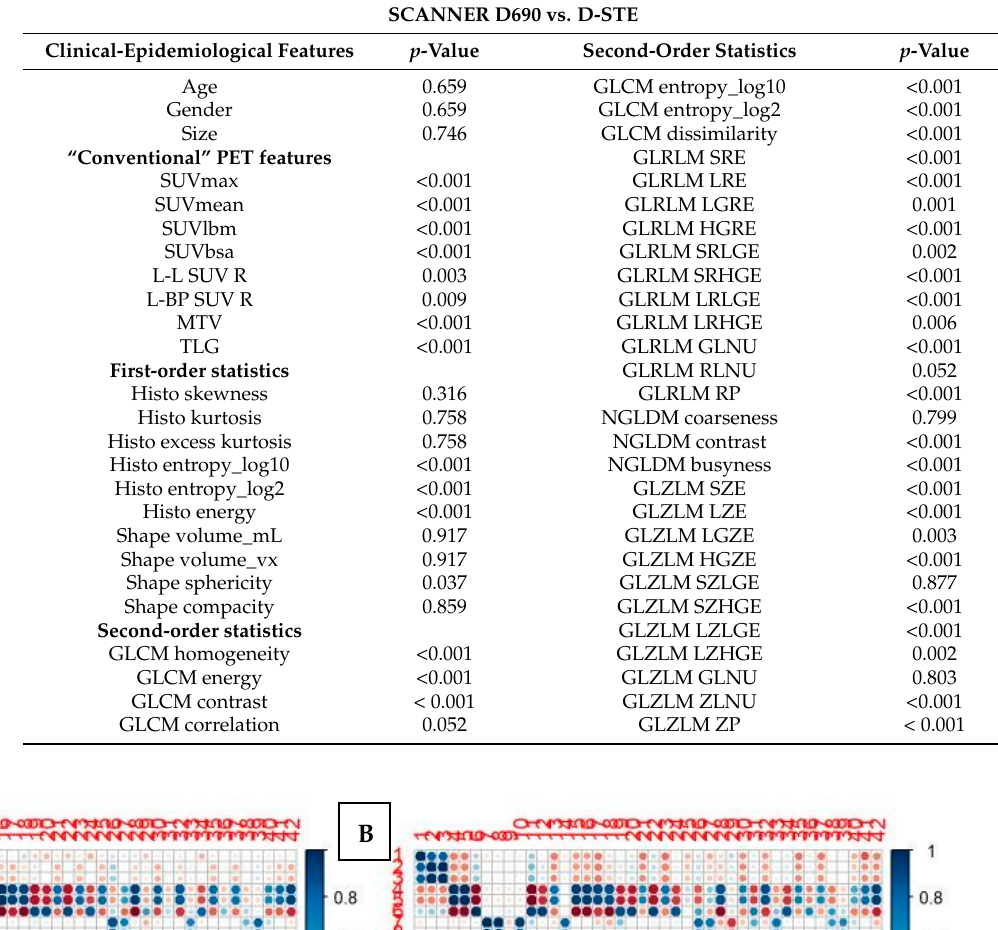
Table 3. Comparison of the clinical, epidemiological, metabolic, and radiomics feature distributions between the two PET scanners.